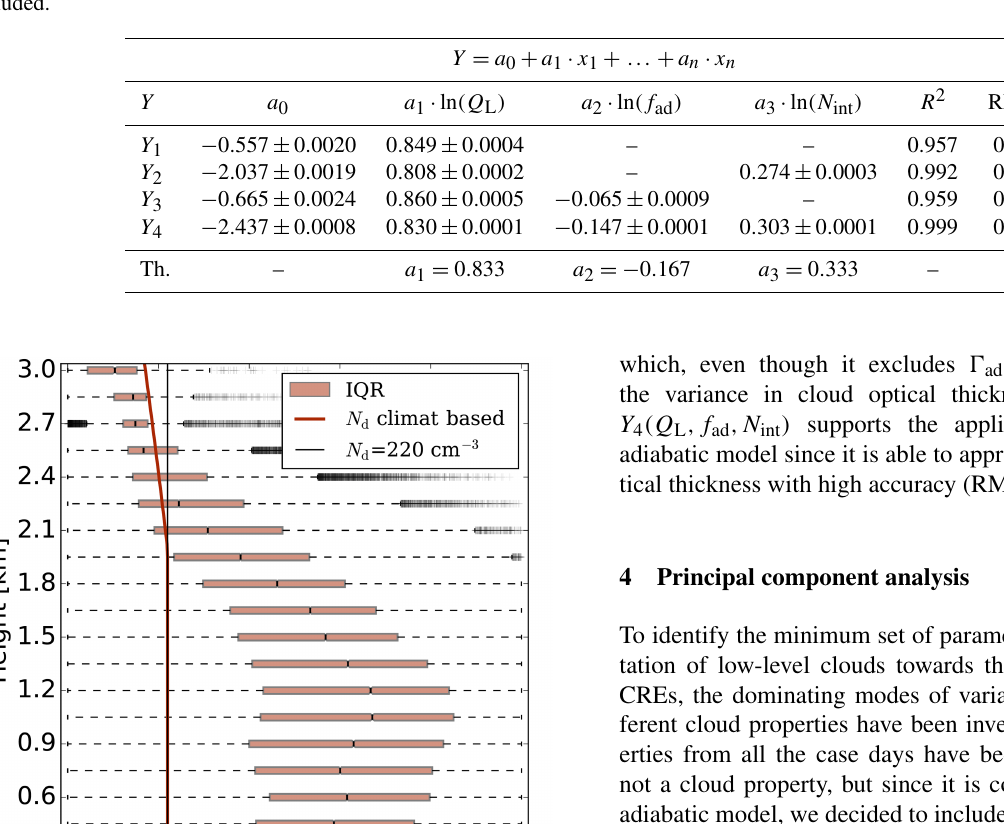
Table 2. Prediction of cloud optical thickness by an ordinary least squares regression method: regressor coefficients ( a ), Y intercept ( a 0 ), squared correlations ( R 2 ), and root mean square error (RMSE). Theoretical (Th.) values according to the sub-adiabatic model are also included.